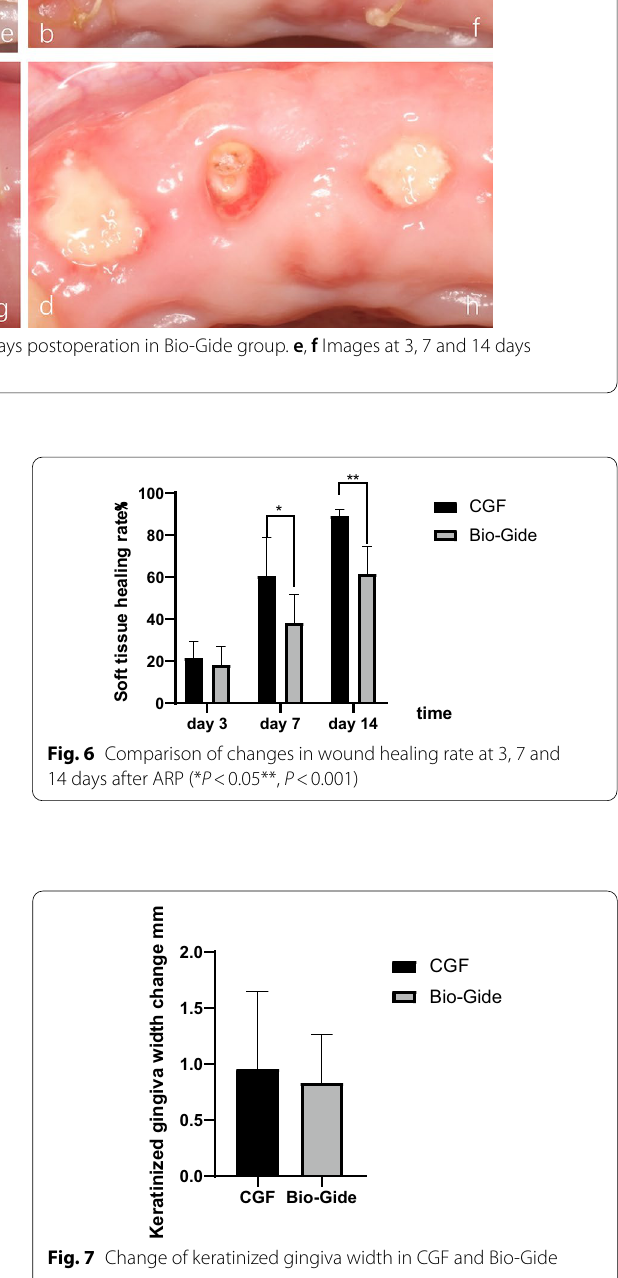
Fig. 7 Change of keratinized gingiva width in CGF and Bio-Gide